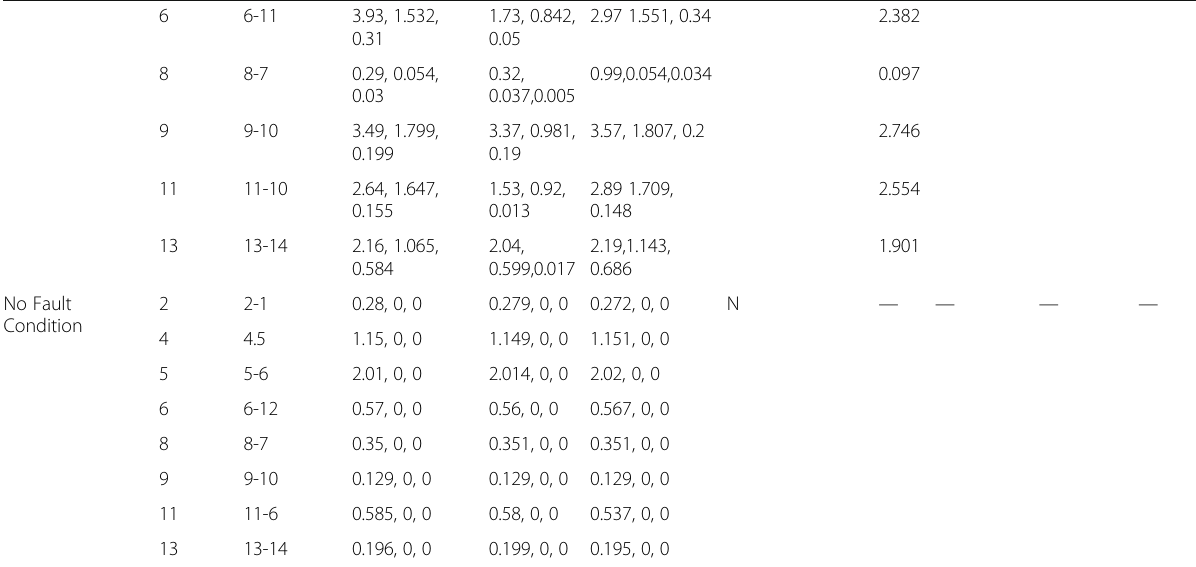
Table 3 Results of case studies conducted on IEEE-14 bus system under various transmission line faults